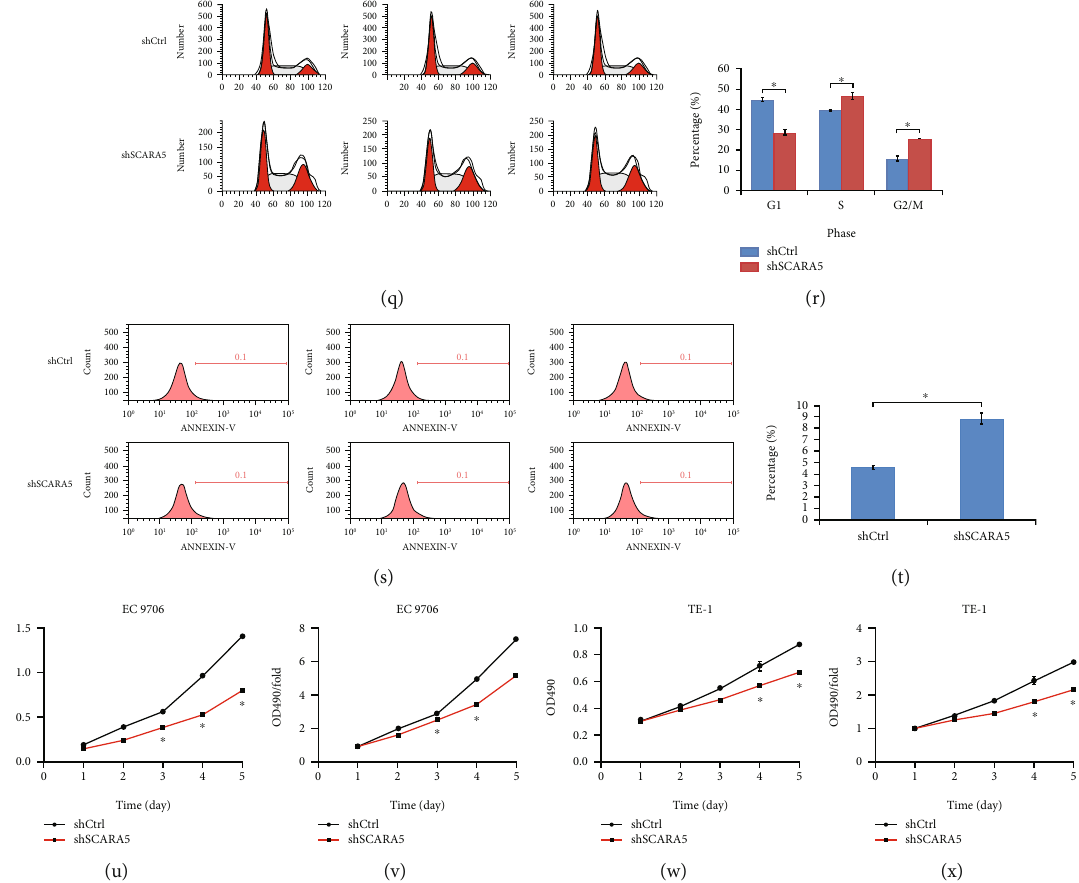
Figure 2: Expression of SCARA5 in the ESCC cells and its impact on cellular proliferation and migration in vitro . (a) Expression of SCARA5 at mRNA level in the Eca109, EC9706, and TE-1 cells was detected using qRT-PCR. (b) Expression of SCARA5 at mRNA level in the Eca109 cells of the KD and the control groups was detected using qRT-PCR. (c) Expression of SCARA5 at protein level in the Eca109 cells of the KD and the control groups was detected using western blot. (d) Fluorescence fi eld pictures of the Eca109 cells from the KD and the control groups were captured by Celigo imaging cytometer for constantly fi ve days. (e – h) E ff ect of SCARA5 knockdown on proliferation of the Eca109 cells was evaluated via MTT assay. (i – k) E ff ect of SCARA5 knockdown on proliferation of the Eca109 cells was evaluated by clone formation assay. (l and m) E ff ect of SCARA5 knockdown on migration of the Eca109 cells was evaluated by wound healing assay. (n – p) E ff ect of SCARA5 knockdown on migration of the Eca109 cells was evaluated by cell invasion assay. (q and r) E ff ect of SCARA5 knockdown on cell cycle of Eca109 cells was evaluated by FCM. (s and t) E ff ect of SCARA5 knockdown on apoptosis of Eca109 cells was evaluated by FCM. (u – x) E ff ect of SCARA5 knockdown on proliferation of the EC9706 and TE-1 cells was evaluated via MTT assay. ∗ P < 0 : 05